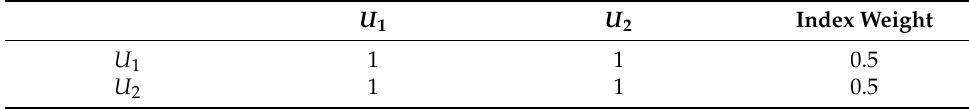
Table 14. Index weight calculation of geological condition.